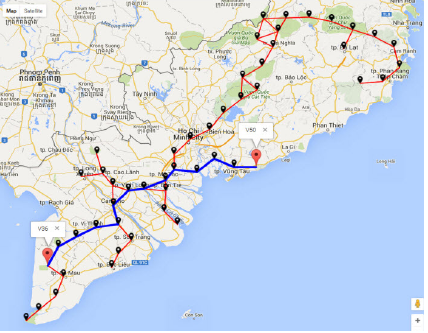
Figure 11. The shortest path for data disseminationfromnode v 50 to gateway node v 36 .